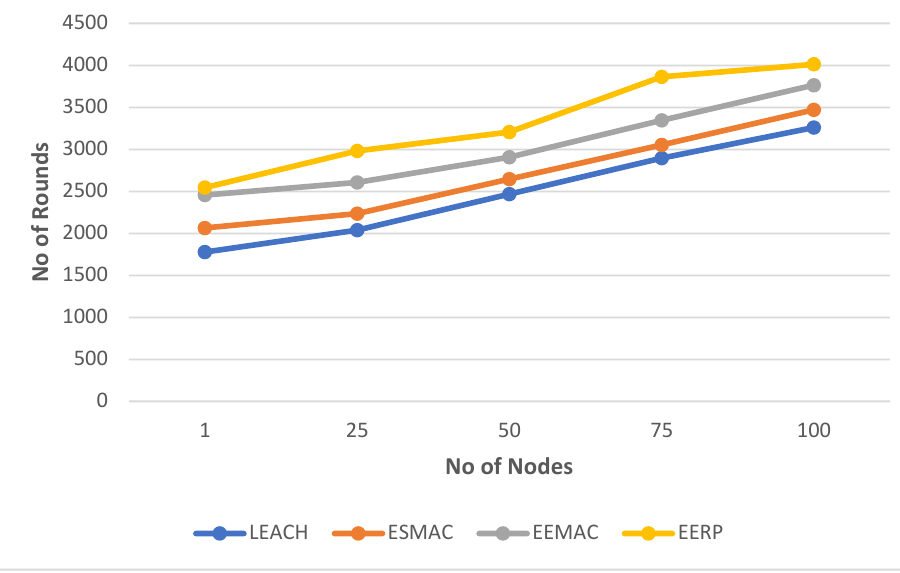
Figure 8. Simulation results in Scenario 1.